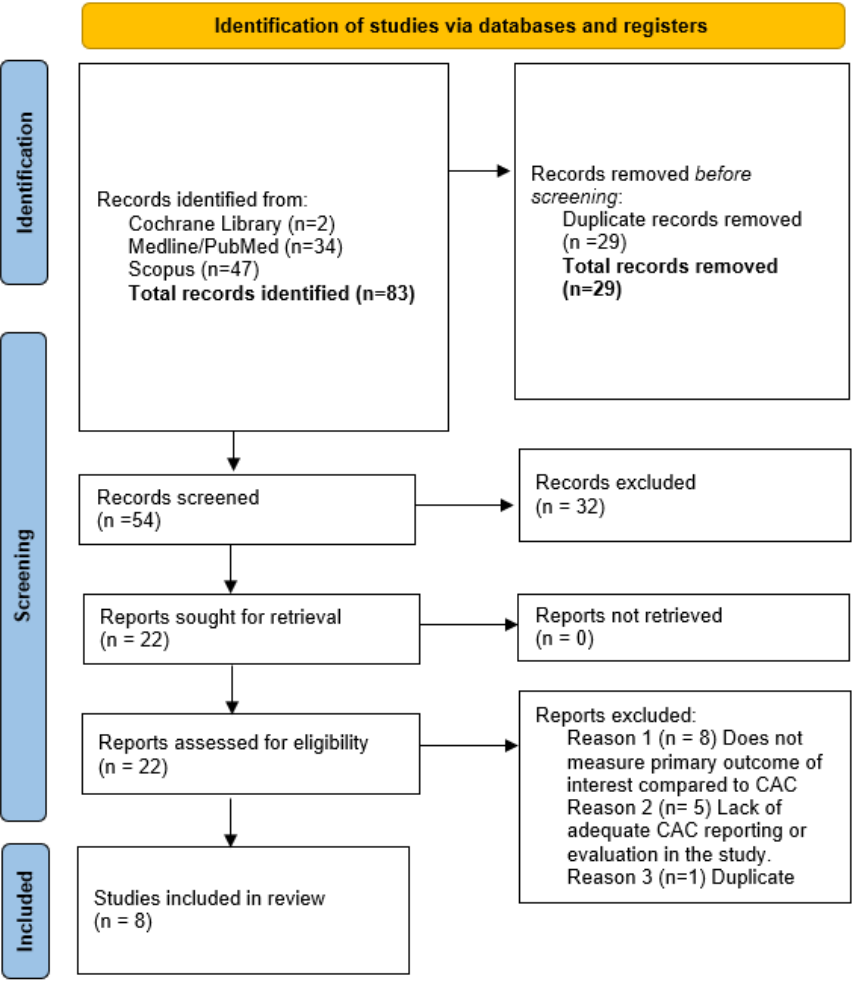
Figure 1. PRISMA flowchart.